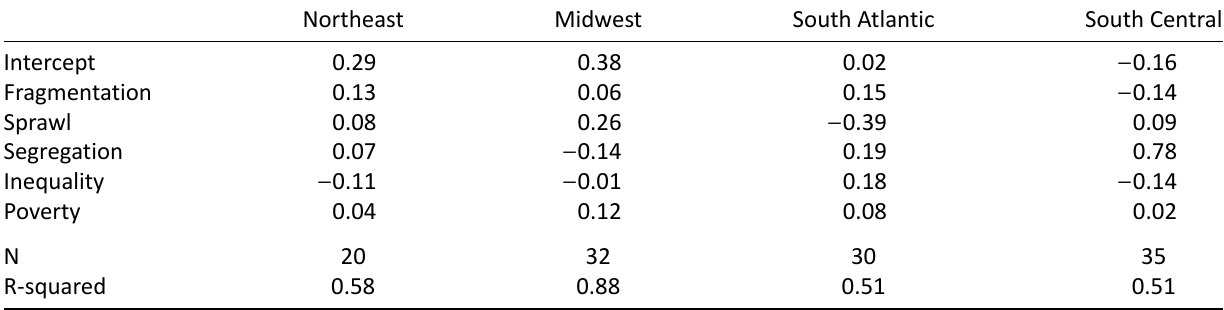
Table 6. Standardized regression coefficients in subgroup analyses relating PRIMED to economic